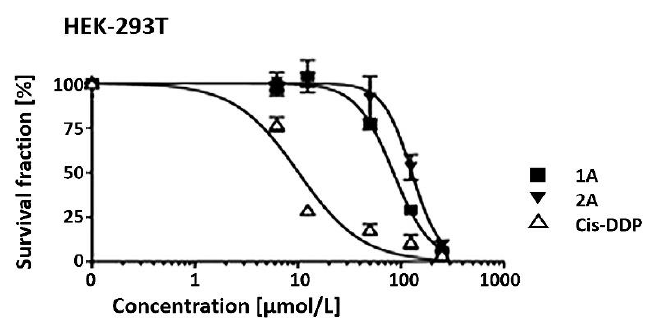
Figure 9. Cell growth inhibitory effects of 1A , 2A vs. cisplatin against human embryonic kidney cell line HEK-293T after 72 h continuous exposure (MTT-dye reduction). Each data point represents the arithmetic mean ± SD of 8 separate experiments.